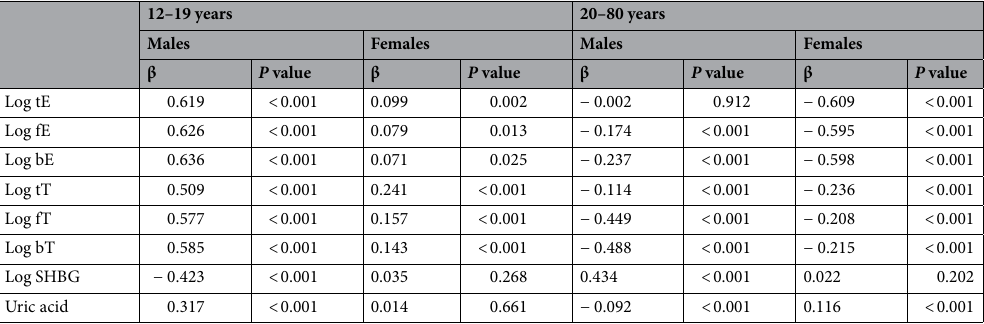
Table 2. Associations of age (independent variable) with log-transformed estradiol, log-transformed testosterone, or uric acid (dependent variables) analyzed by weighted least squares regression. bE, fE or tE bioavailable, free or total estradiol; bT, fT or tT bioavailable, free or total testosterone; SHBG sex hormone- binding